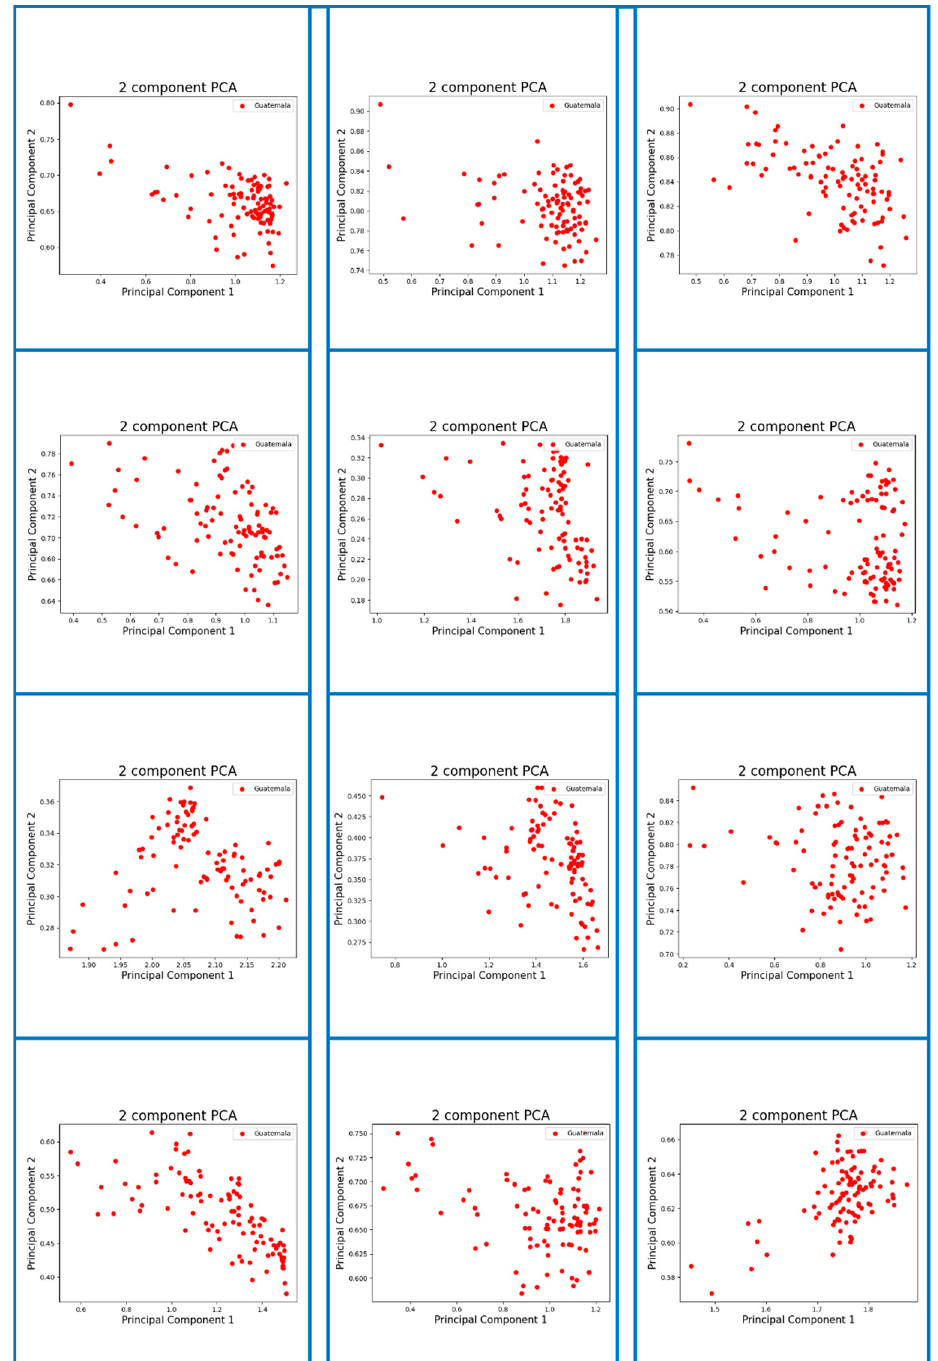
Figure A3. Sample digital fingerprints of coffee aromas originating from Huehuetenango, Guatemala.